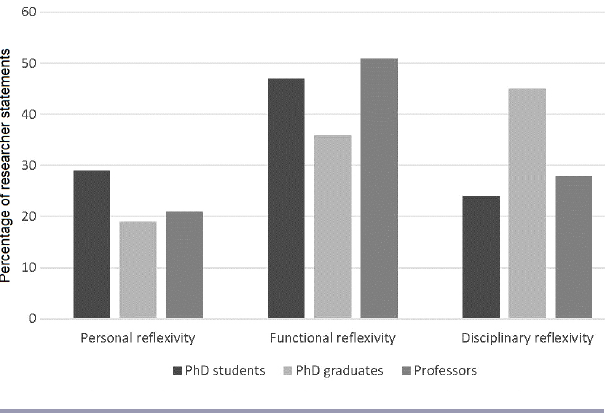
Fig. 1. Percentage of researcher statements concerning each type of reflexivity for three career